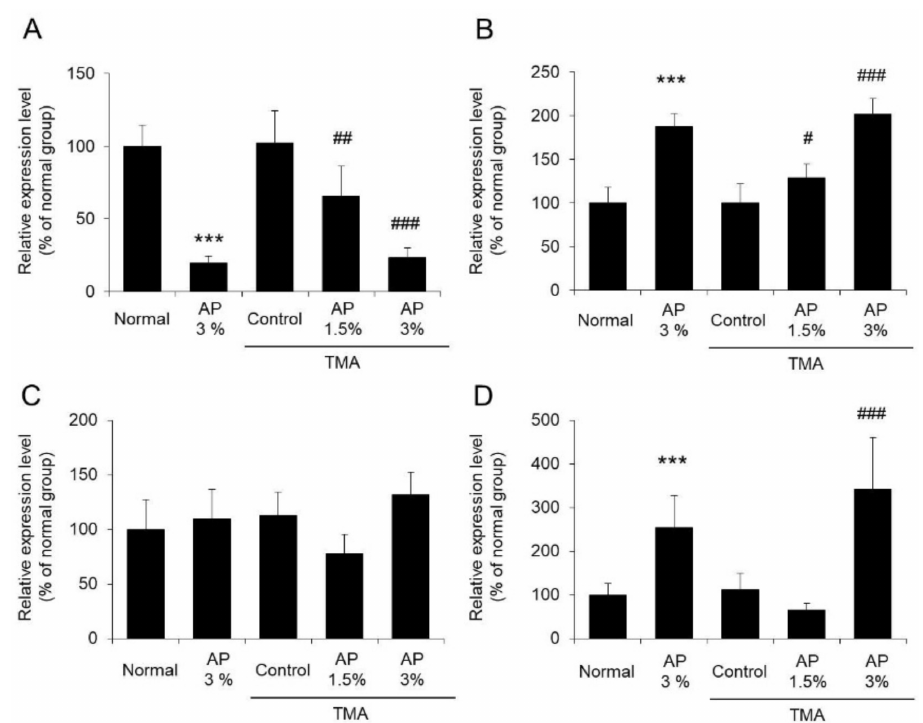
Figure 5. The phyla Firmicutes ( A ), Bacteroidetes ( B ) , Proteobacteria ( C ), and Actinobacteria ( D ). Mice with atopic dermatitis induced by repeated application of TMA were given a diet with AP. The feces were collected from the colon, and the abundances of the phyla Firmicutes ( A ), Bacteroidetes ( B ), Proteobacteria ( C ), and Actinobacteria ( D ) in the gut microbiota were measured using real-time PCR (mean ± SD, N = 8, *** p < 0.001 vs. normal group, # p < 0.05 vs. TMA-control group, ## p < 0.01 vs. TMA-control group, ### p < 0.001 vs. TMA-control